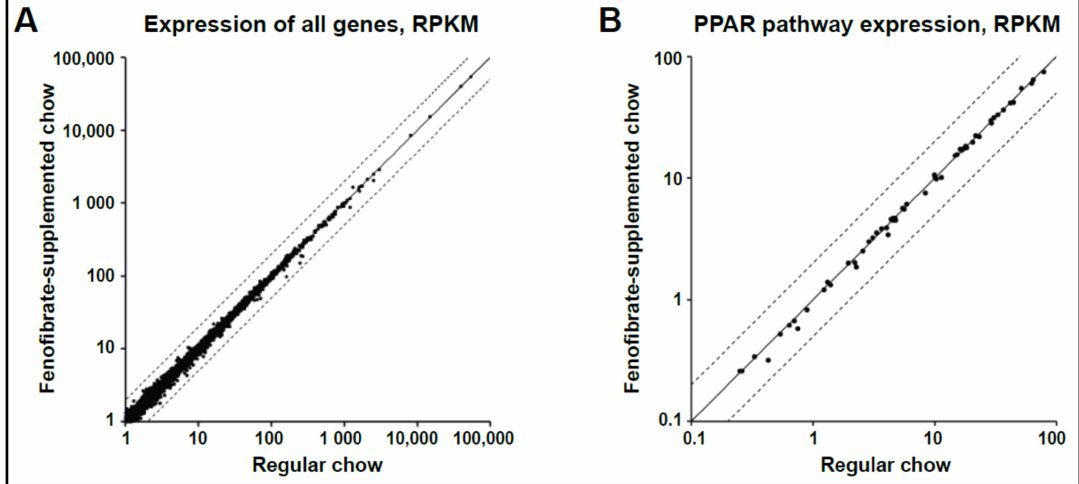
Figure 3. Gene expression is unchanged in whole retinas isolated from mice treated with a fenofibrate-supplemented diet. Beginning at one month of age, mice were maintained on a fenofibrate-supplemented or regular chow diet, with four male, and four female mice per group. They were harvested at six months of age. RNA was isolated from whole retinas and gene expression assessed using RNA-seq. Each point represents the normalized expression of a single gene in reads per kilobase per million mapped reads (RPKM). The solid line represents equal expression in the two groups, while the dashed lines represent a 2-fold difference in gene expression. ( A ) Gene expression in all genes. ( B ) Gene expression in the subset of genes belonging to the PPAR pathway (as annotated in